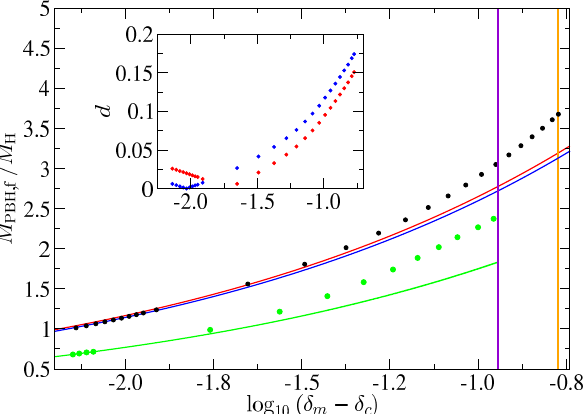
Figure 22. Values of M PBH, f / M H in terms of ( δ m − δ c ) for two Gaussian profiles in K ( r ) and ζ ( ˜ r ) . Dark points correspond to the numerical values for the profile in K ( r ) . The solid red line corresponds to the scaling law behaviour with γ = 0.357, δ c = 0.49774 for K = 6.03 (pointed out in [94]) and the blue solid line with the numerical value obtained in the review with K = 5.91. The absolute value of the relative deviation d with respect to the numerical values and the ones coming from the scaling law are shown in the subplot. The orange vertical line is the value δ max = 2/3. On the other hand, the green dots correspond to the case of the Gaussian profile in ζ . The solid green line is the scaling law with γ = 0.357, δ c = 0.55257, and K = 3.98 (in [106], for this profile, K (cid:39) 4.0 was given). The vertical magenta line corresponds to the case δ max = 2/3 for this profile. In both cases, w =